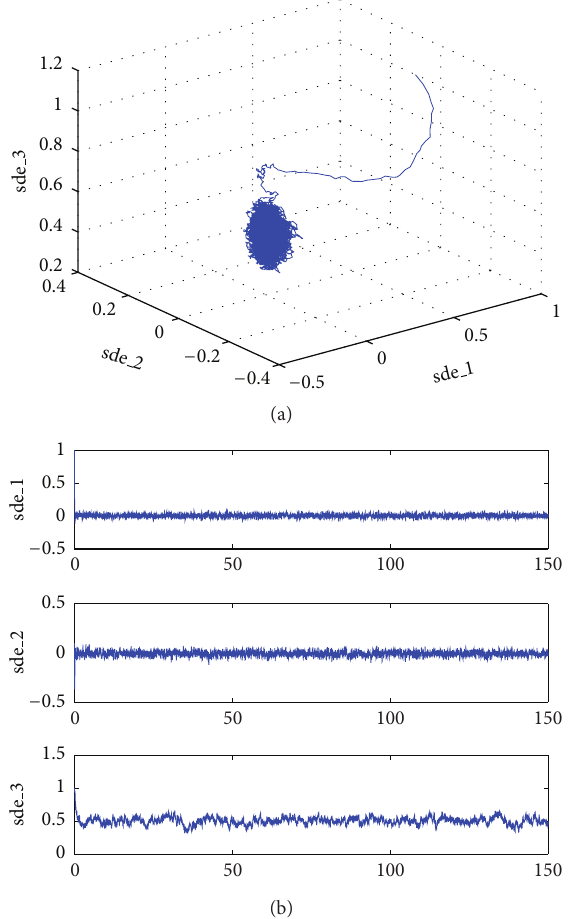
Figure 12: Deterministic